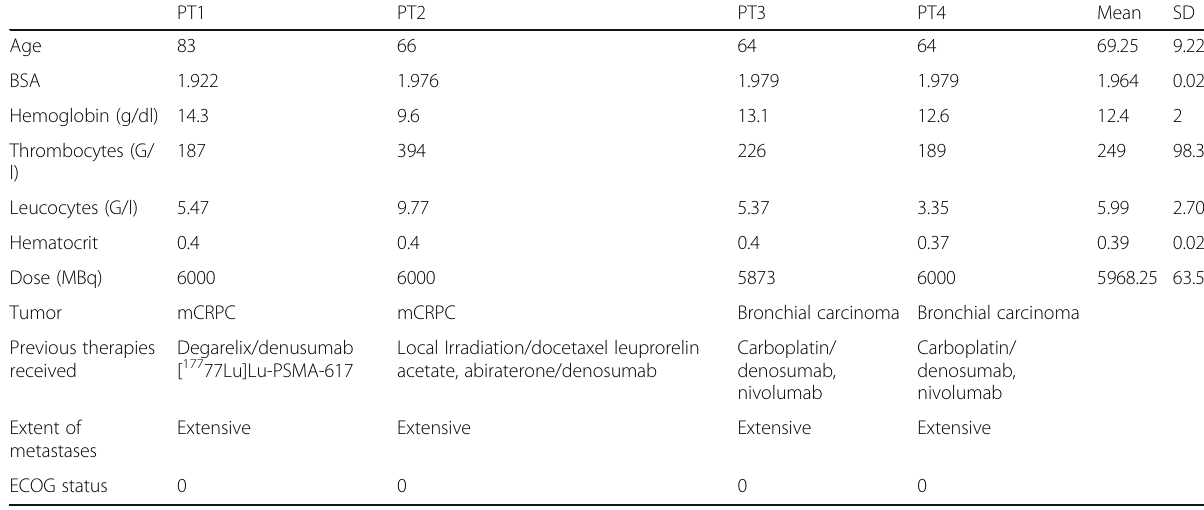
Table 1 Subject details of patients receiving radionuclide therapy with [ 177 Lu]Lu-DOTA ZOL PT1 PT2